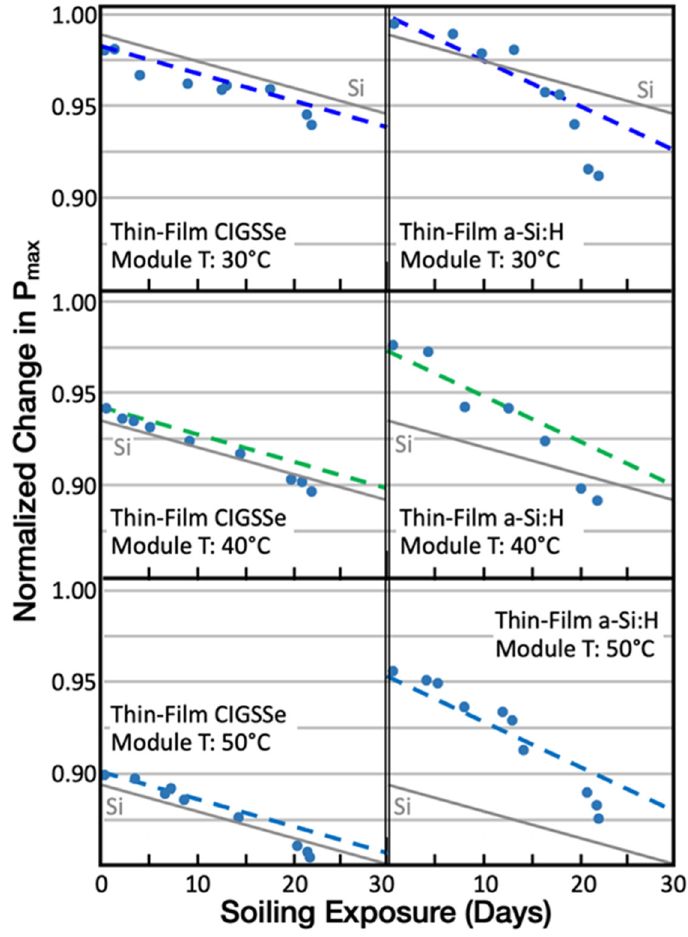
Figure 12. Comparison of experimental data with model predictions (lines) for CIGSSe and a-Si:H thin-film modules (dashed lines) to Si module (solid line) over a dry period of 24 days.